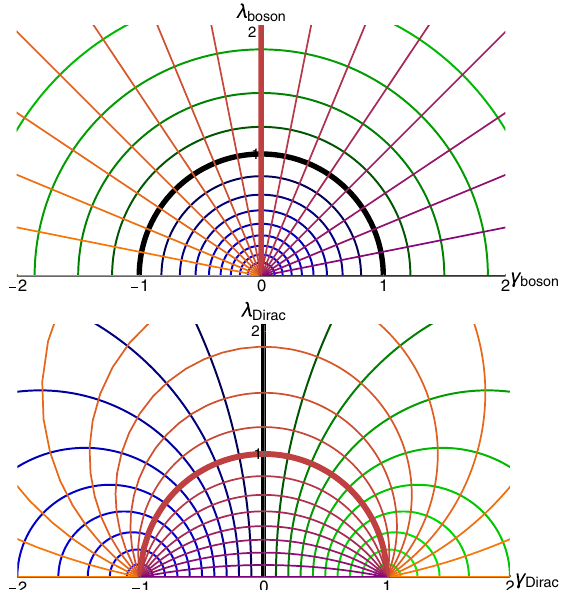
FIG. 2. Equation (4) describes a conformal map from the complex half-plane onto itself. The upper figure depicts (orthogo- nal) lines of fixed radius or angle. The lower figure shows the same lines in the transformed coordinate system. A number of important special cases are as follows: (i) Purely imaginary z , boson corresponding to time-reversal-invariant boson systems, map 1 for fermions, i.e., self-dual onto the unit circle j z Dirac j ¼ → i ∞ and z i 0 þ correspond to models. The limits z boson boson ¼ 1 and z − 1 , i.e., the fermion models with half- z Dirac ¼ þ Dirac ¼ integer Chern-Simons described in Eq. (1). (ii) Self-dual boson 1 , map onto purely imaginary z models, j z boson j¼ Dirac ¼ i tan ½ arg ð z = 2 (cid:2) , i.e., time-reversal invariant fermions. (iii) The boson Þ z i is invariant under the conformal special point z boson ¼ Dirac ¼ map and corresponds to a model that is simultaneously self-dual and time-reversal invariant for both bosons and